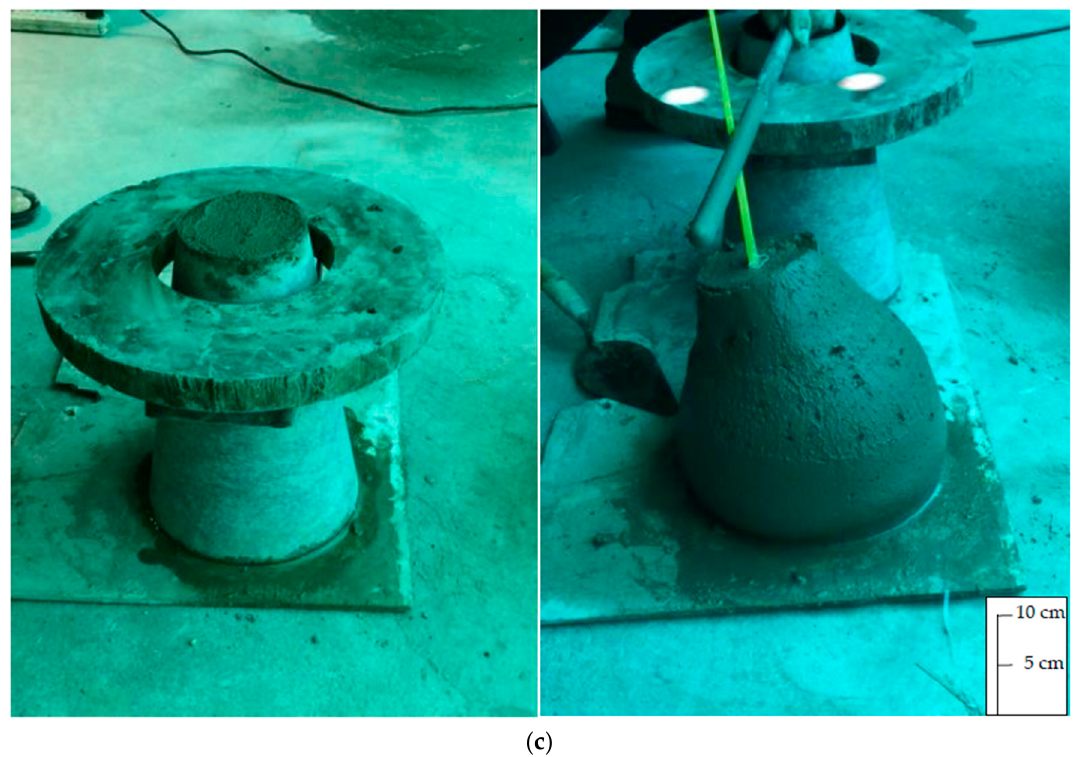
Figure 4. Photographs of workability test during concrete processing: ( a ) Complex network of 20 vol % HDPE fibers in concrete, ( b ) Segregation of 30 vol % PP fibers in concrete, and ( c ) Mortar (control sample without plastic